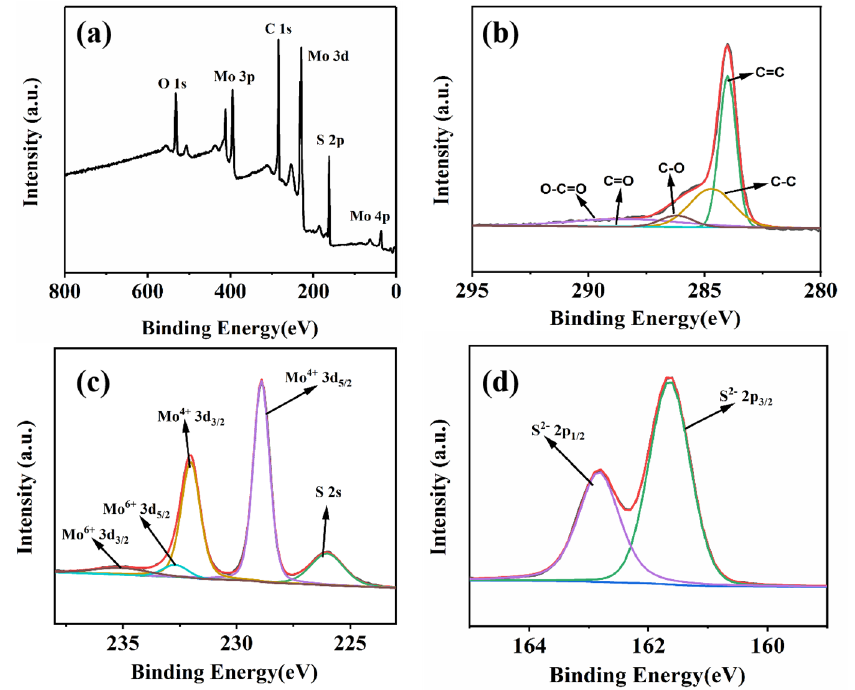
Figure 6. XPS spectrum of ( a ) MoS 2 /rGO/GQDs, ( b ) C 1s XPS spectrum of MoS 2 /rGO/GQDs, ( c ) Mo 3d XPS spectrum of MoS 2 /rGO/GQDs and ( d ) S 2p XPS spectrum of MoS 2 /rGO/GQDs.